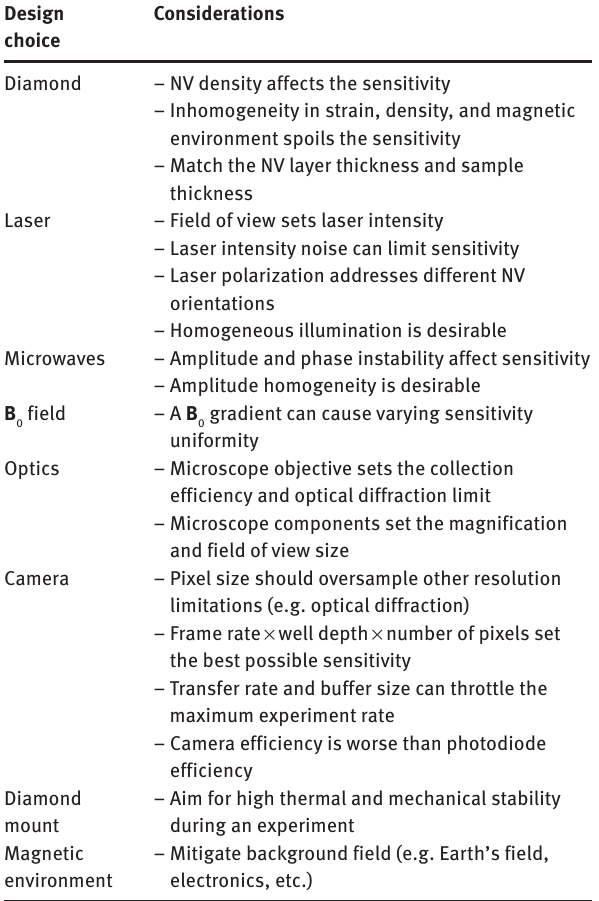
Table 2: General QDM hardware considerations that apply to all measurement